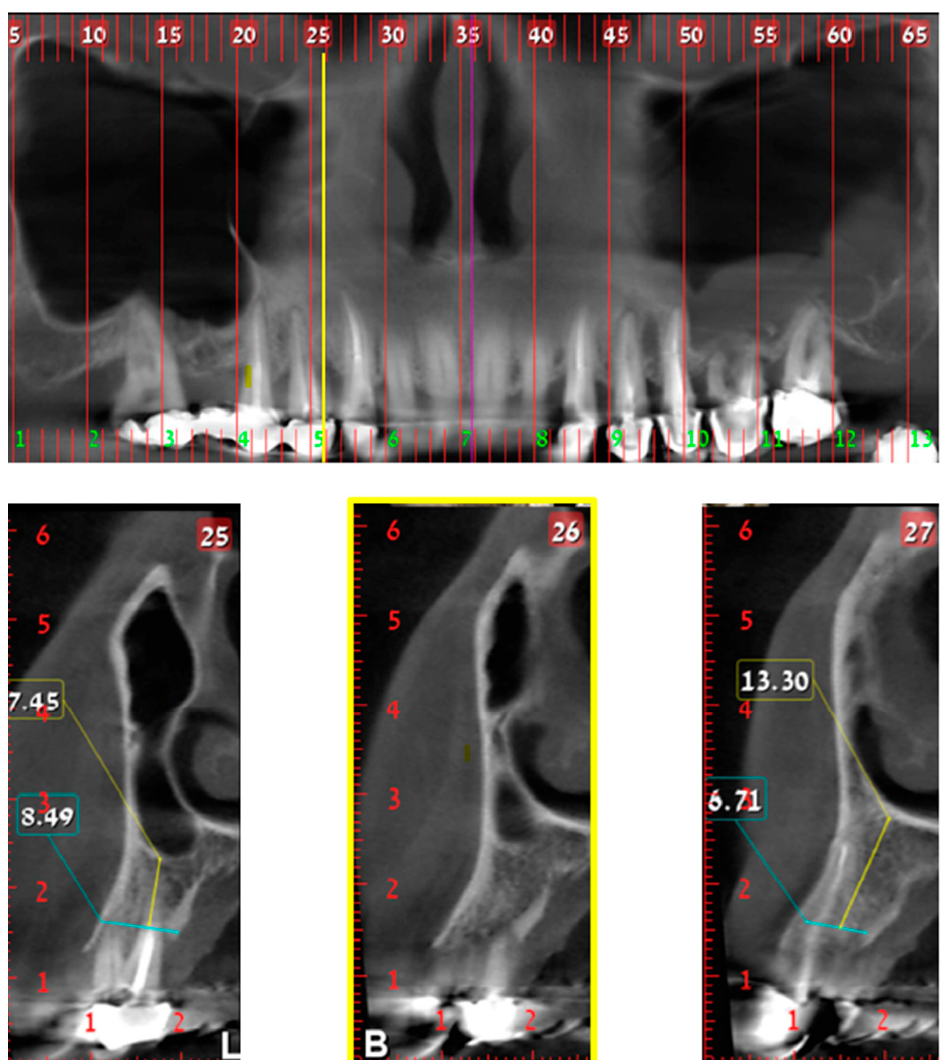
Figure 1. Class 1; Upper part—CBCT panoramic reconstruction; Lower part—from right to left—CBCT cross sections: cross section number 27—demonstrate nasal cavity alone above the alveolar ridge; cross section number 26—yellow line and frame—demonstrate nasal and maxillary sinus “border cross section”, which is located above the distal part of the canine, defined as Class 1; cross section number 25—demonstrate one cross section distal to the “border cross section”. B, buccal; L, lingual. Class 1—“border cross section” is located MD up to the distal edge of the canine. Class 2—“border cross section” is located MD up to the distal edge of 2nd premolar. Class 3—“border cross section” is located distal to the mesial edge of the 1st molar. Classes 1 and 2 were defined as normal anatomy and Class 3 as “big-nose